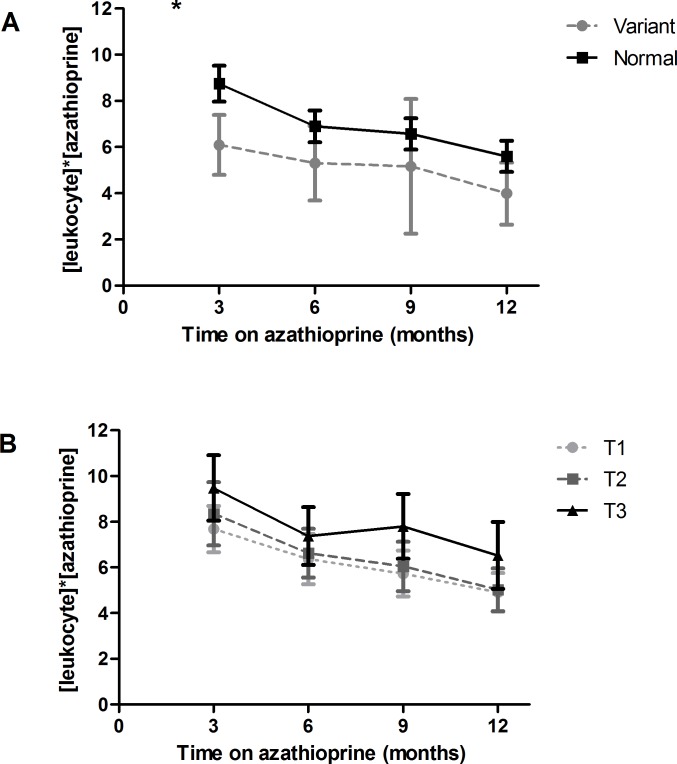
[leuko]*[aza] product over time for TPMT genotypes and tertiles of TPMT activity.[leukocyte]*[azathioprine] product 3,6,9 and 12 months after switch to azathioprine. *P<0.05. Upper graph (4A): Variant = heterozygous TPMT variant carrier; Normal = normal genotype (wildtype TPMT). Lower graph (4B): T1 = lowest tertile, T2 = middle tertile, T3 = highest tertile of TPMT activity.